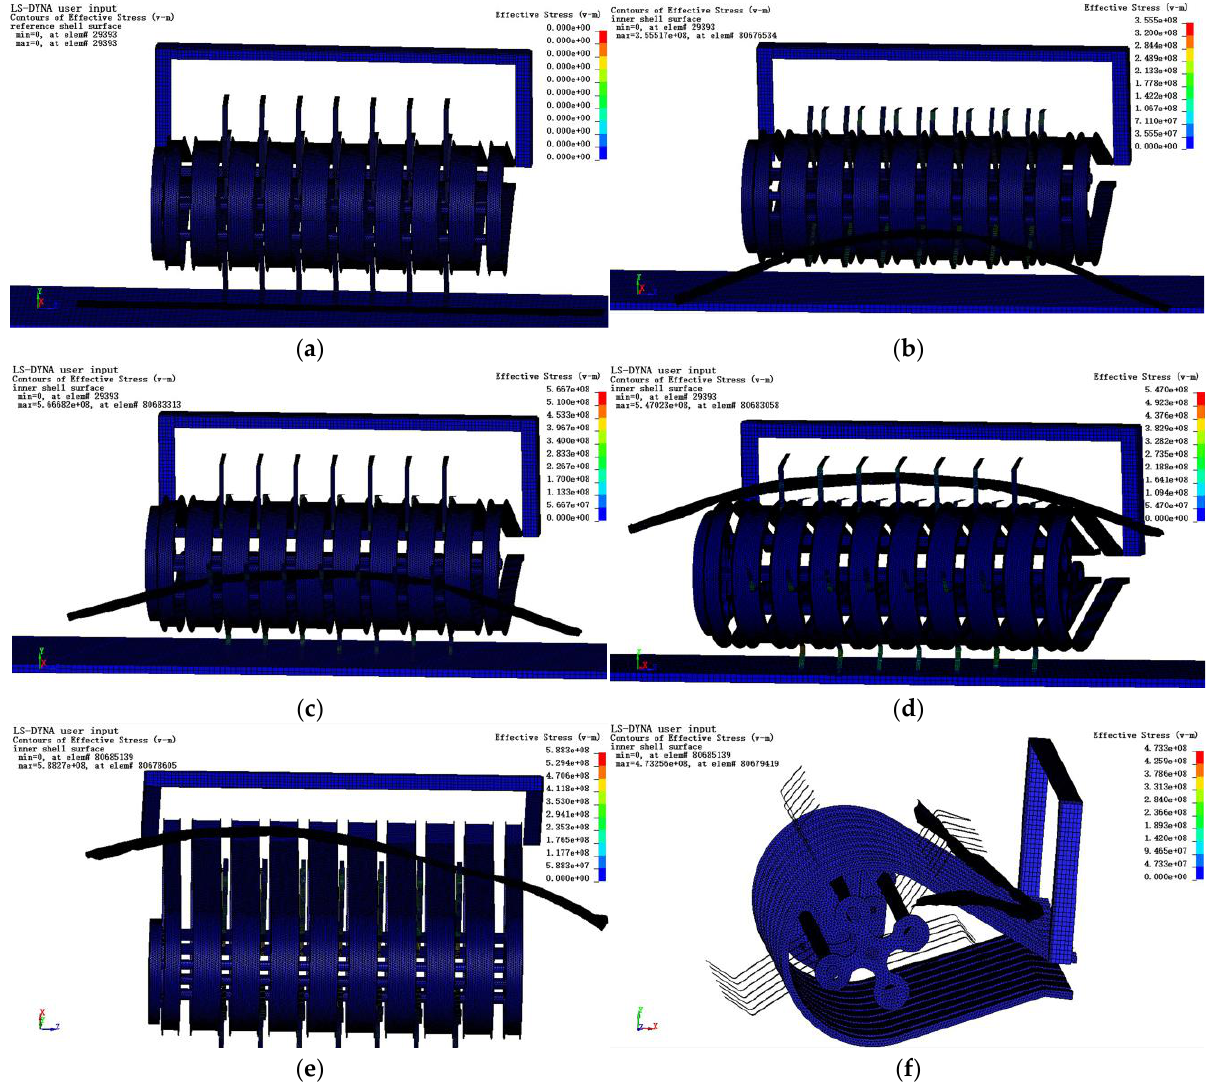
Figure 6. Stress clouds and motion posture of sugarcane leaf. ( a ) represents the stress and posture diagram of the cane leaf at T = 0 s; ( b ) represents the stress and posture diagram of the cane leaf at T = 0.25 s; ( c ) represents the stress and posture diagram of the cane leaf at T = 0.41 s; ( d ) represents the stress and posture diagram of the cane leaf at T = 0.85; ( e ) represents the stress and posture diagram of the cane leaf at T = 1.47 s; and ( f ) represents the stress and posture diagram of the cane leaf at T = 1.80 s. At t = 1.55 s, the maximum value of stress on the leaf vein also occurred near